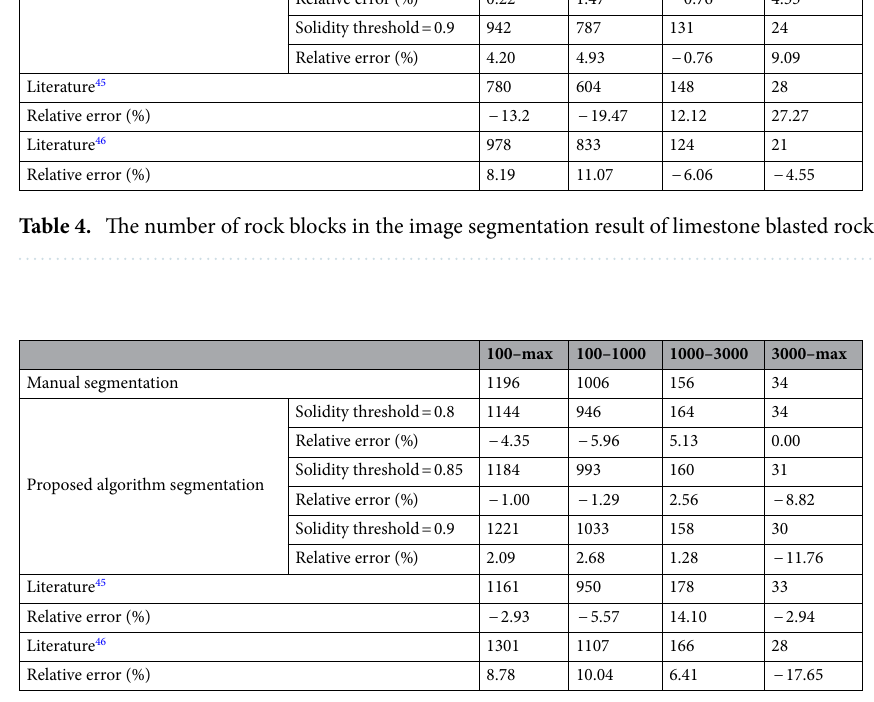
Table 5. The number of rock blocks in the image segmentation result of granite blasted rock